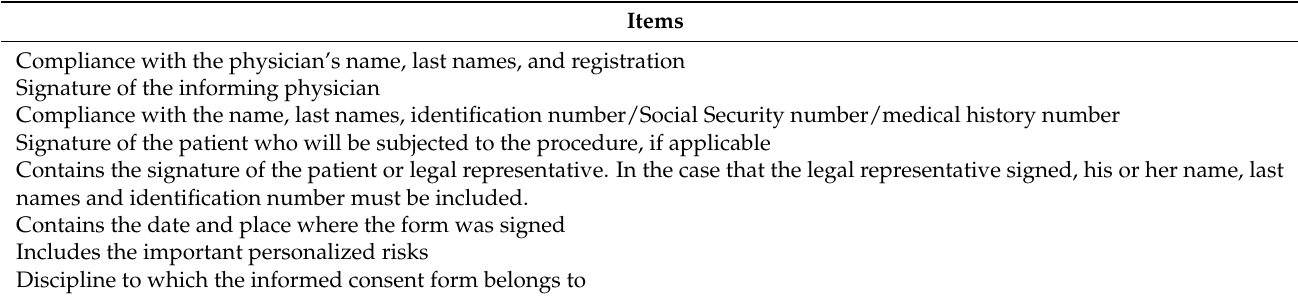
Table 2. Form for assessing the compliance with the informed consent forms.